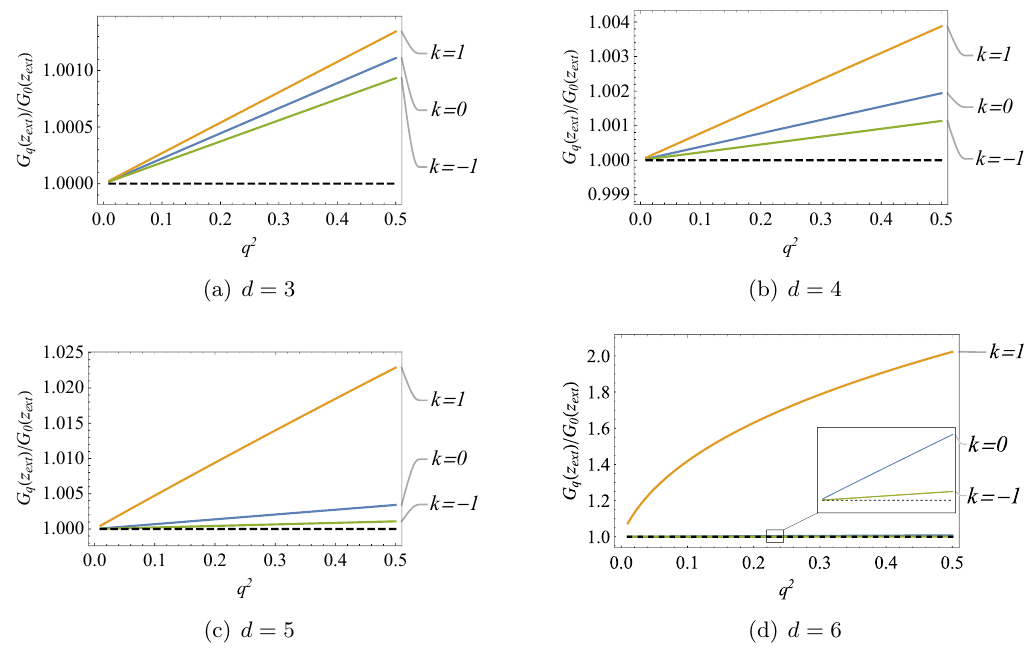
Figure 10 . For the case of ‘ AdS = 1 and fixed temperature T = 5 G q ( z ext ) /G 0 ( z ext ) , where G 0 ( z ext ) is the maximum growth rate of vacuum case. The horizontal axis represents the charge parameter q 2